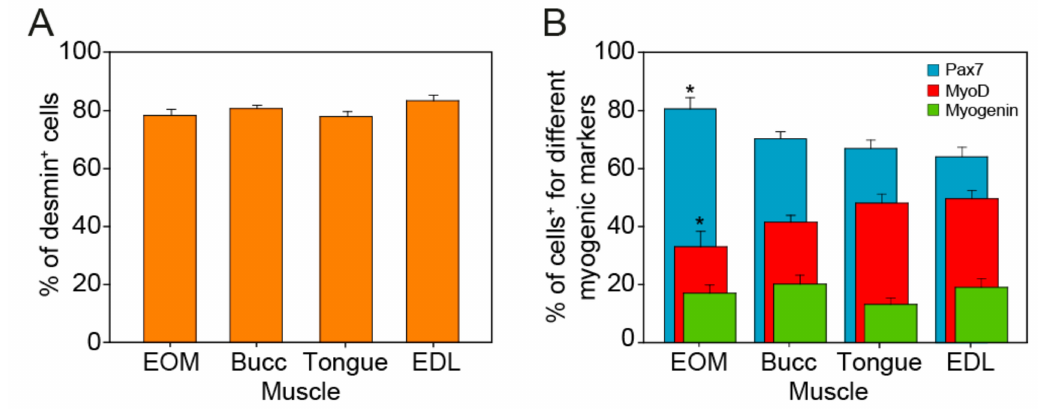
Figure 2. Percentage of myogenic cells obtained from the muscles under study. ( A ) Bar charts comparing the mean and SEM of the percentage of desmin + cells on progenitors derived from each muscle. ( B ) Bar charts comparing the mean and SEM of the percentage of immunostained cells for each marker (Pax7: blue, MyoD: red, Myogenin: green) on progenitors derived from each muscle. Asterisk (*) indicates significant di ff erences with cells derived from tongue and EDL (one-way ANOVA, Holm–Sidak method for post-hoc comparisons, P <